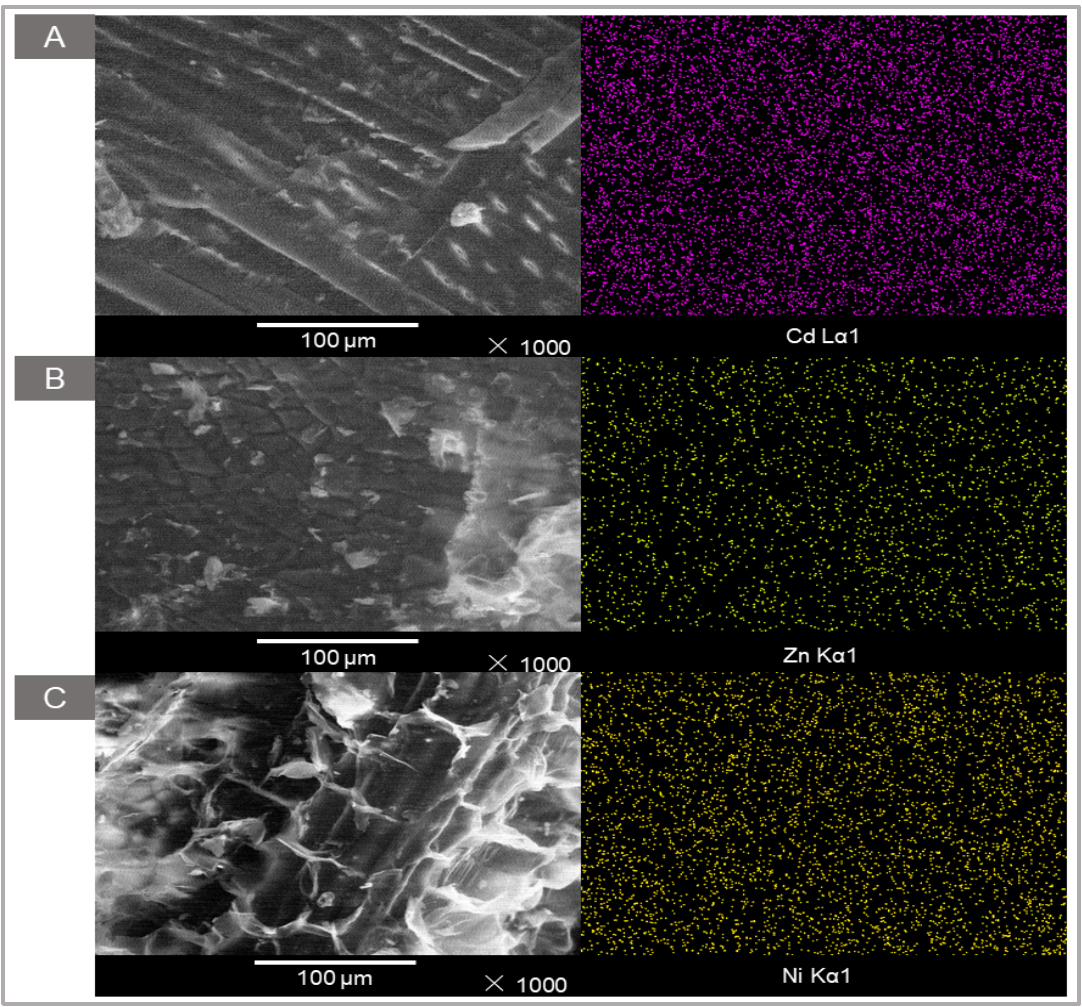
Figure 4. Elemental distribution obtained by SEM-EDS by mapping analysis for ( A ) pine sawdust, ( B ) sunflower seed hulls, ( C ) corn residues mix, after adsorption of Cd(II), Zn(II) and Ni(II), respec- tively.